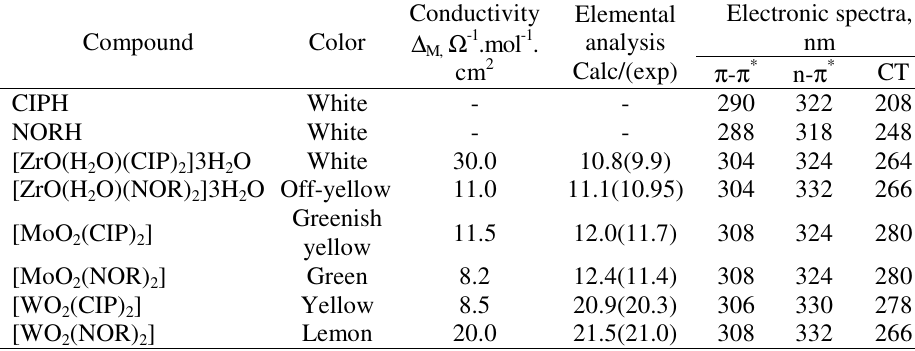
Table 1. Physical properties and UV-visible spectra of the ligands and their